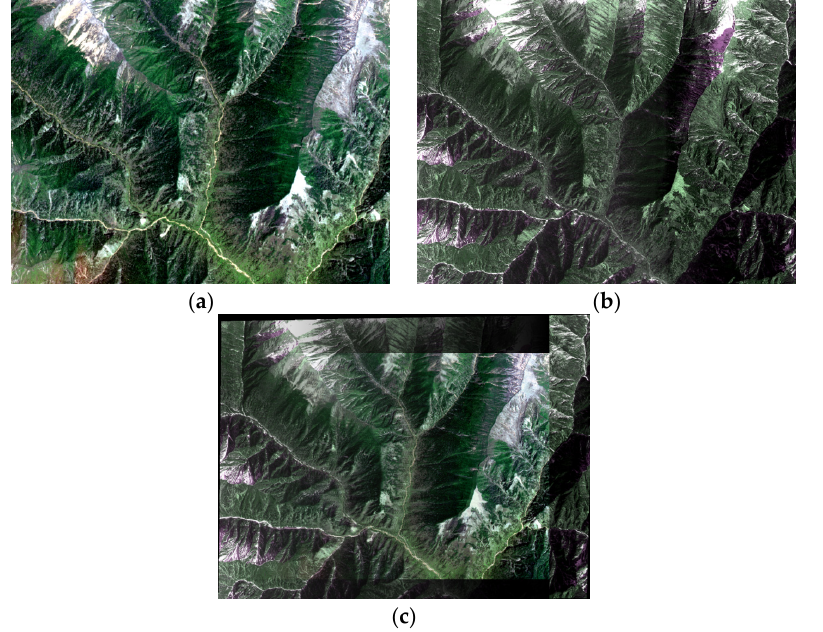
Figure 11. A multi-source image pair: ( a ) Acquired by GF-1 on 19 February 2015 (800 × 600); ( b ) acquired by GF-2 on 24 February 2015 (2400 × 1800); ( c ) the stitched multi-source image. Table 4. Comparison of the TAR and RANSAC algorithms for multi-source image images. Number of Pairs by Match Methods Match